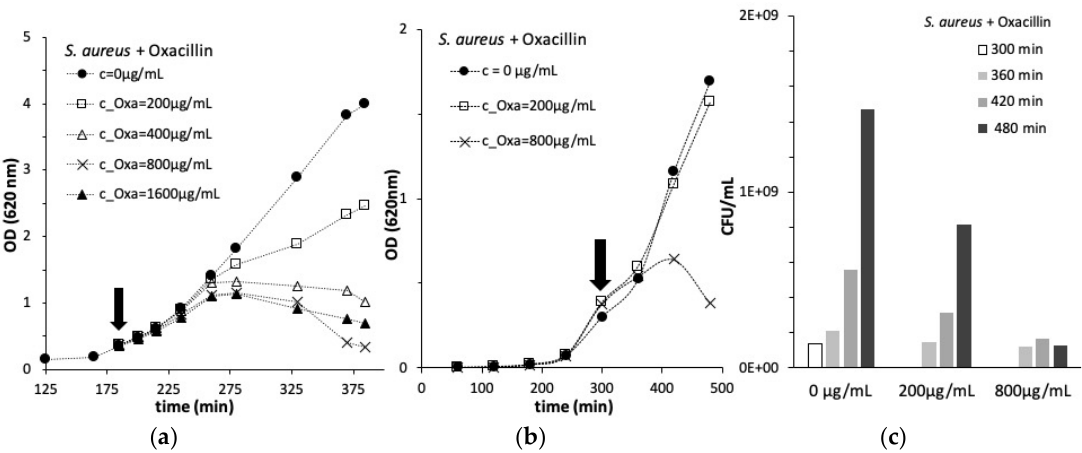
Figure 1. ( a ) Growth curves of S. aureus strain COL growth monitored by measuring the optical density (OD 620 nm ) over time. S. aureus was grown in the absence and in the presence of different concentrations of oxacillin (Oxa), at 200, 400, 800 and 1600 µg/mL added at t = 180 min (representative curves). The arrow represents the time of addition of the antibiotic to the culture. ( b ) Growth curves of S. aureus strain COL grown in the absence and in the presence of different concentrations of antibiotics: oxacillin (Oxa) at 200 and 800 µg/mL added at 300 min (representative curves). The arrow represents the time of addition of the antibiotic to the culture. ( c ) Colony forming units (CFU/mL), at specific growth times: 300, 360, 420 and 480 min after the addition of oxacillin. All the measurements were performed at 37 °C.